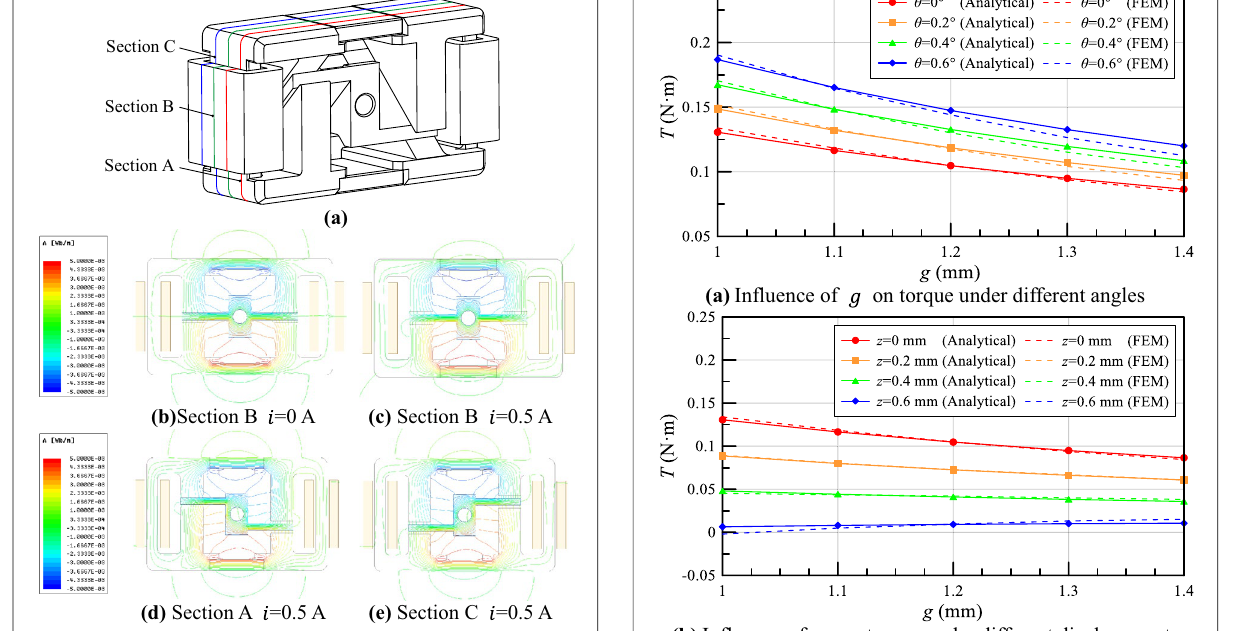
Figure 14 Distribution of magnetic flux lines of REMC-NFM under different